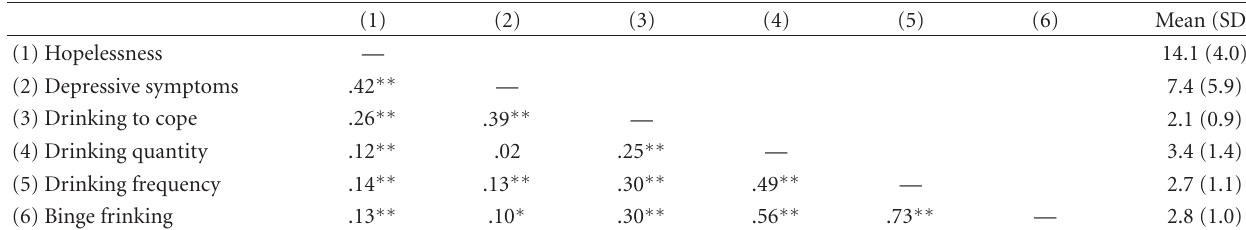
Table 1: Descriptive statistics and bivariate correlations between study